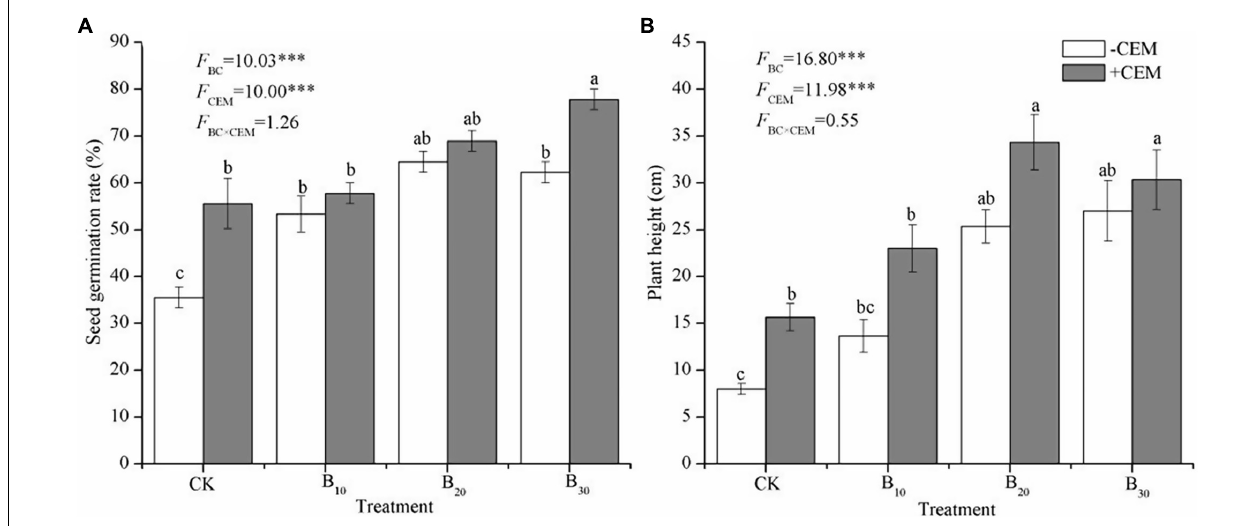
FIGURE 1 | Alfalfa seed germination rate (A) and alfalfa plant height (B) under different treatments. Bars and error bars show means ± SE ( n = 5). Different lowercase letters referred to significant difference between treatments ( p < 0.05). The F BC , F CEM , and F BC × CEM are F and the degree of freedom of two-way ANOVAs. ∗∗∗ p <